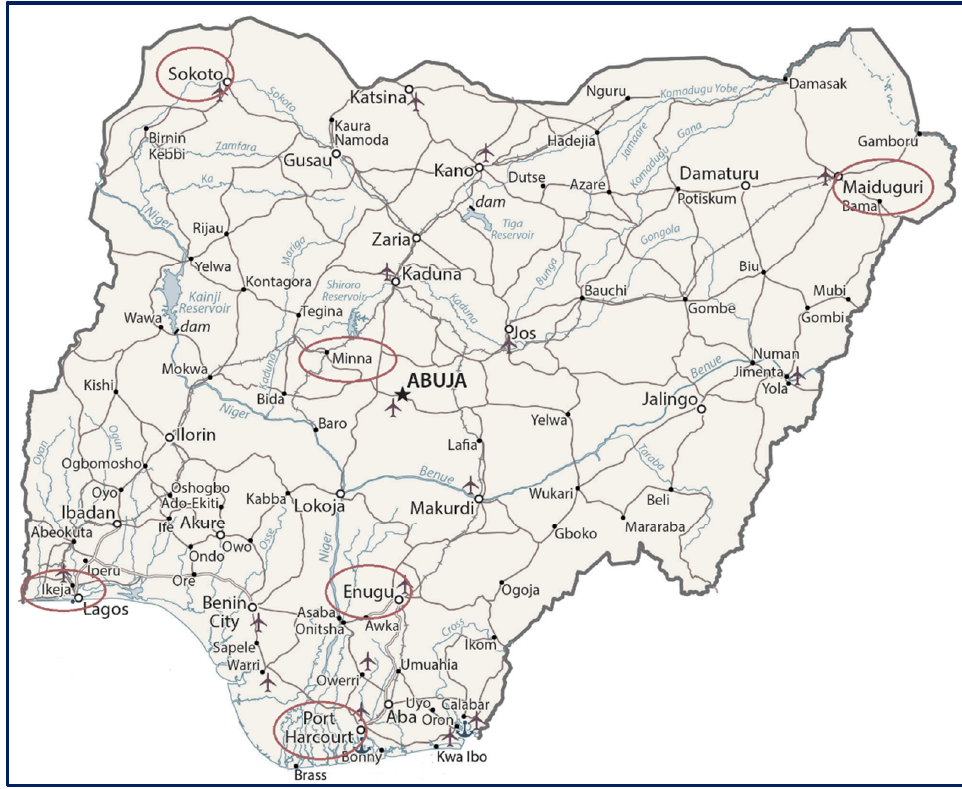
Figure 2. The map of Nigeria showing the case study sites. The star in the middle denote Abuja, the Capital of Nigeria. Table 3. Geographical coordinates of the case study sites.